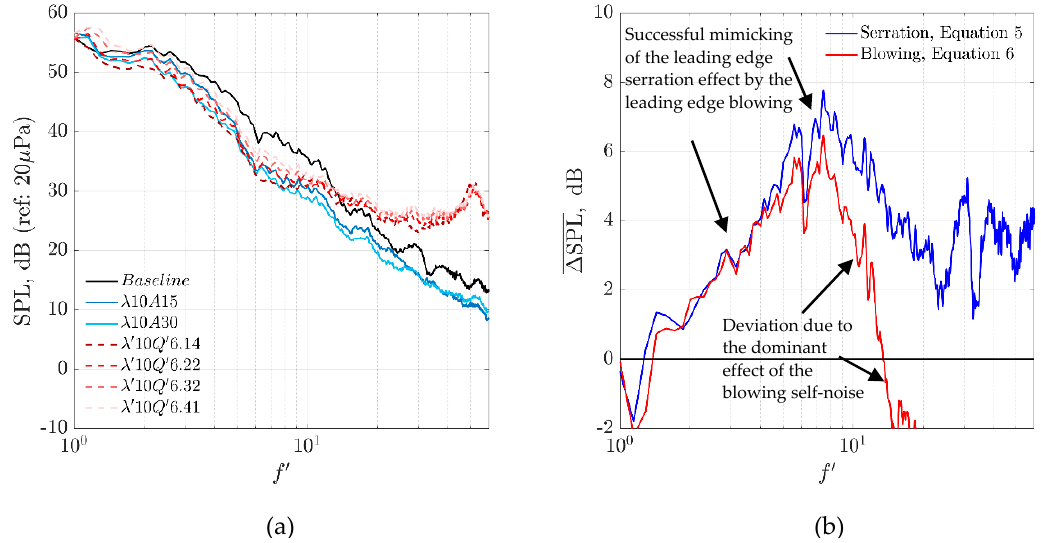
Figure 9. Comparison of ( a ) SPL as a function of normalized frequency f ‘ produced by the serrated leading edges (blueish solid lines: λ 10 A 15 and λ 10 A 30) and the blowing leading edges (reddish broken lines: λ ’ 10 Q ‘ 6.14, λ ’ 10 Q ‘ 6.22, λ ’ 10 Q ‘ 6.32 and λ ’ 10 Q ‘ 6.41) at U = 45 ms − 1 and α = 0°. Take note of the matching λ and λ ‘ between the serrated and blowing leading edges; ( b ) the corresponding Δ SPL for the serration (Equation 5) and blowing (Equation 6) leading edges.